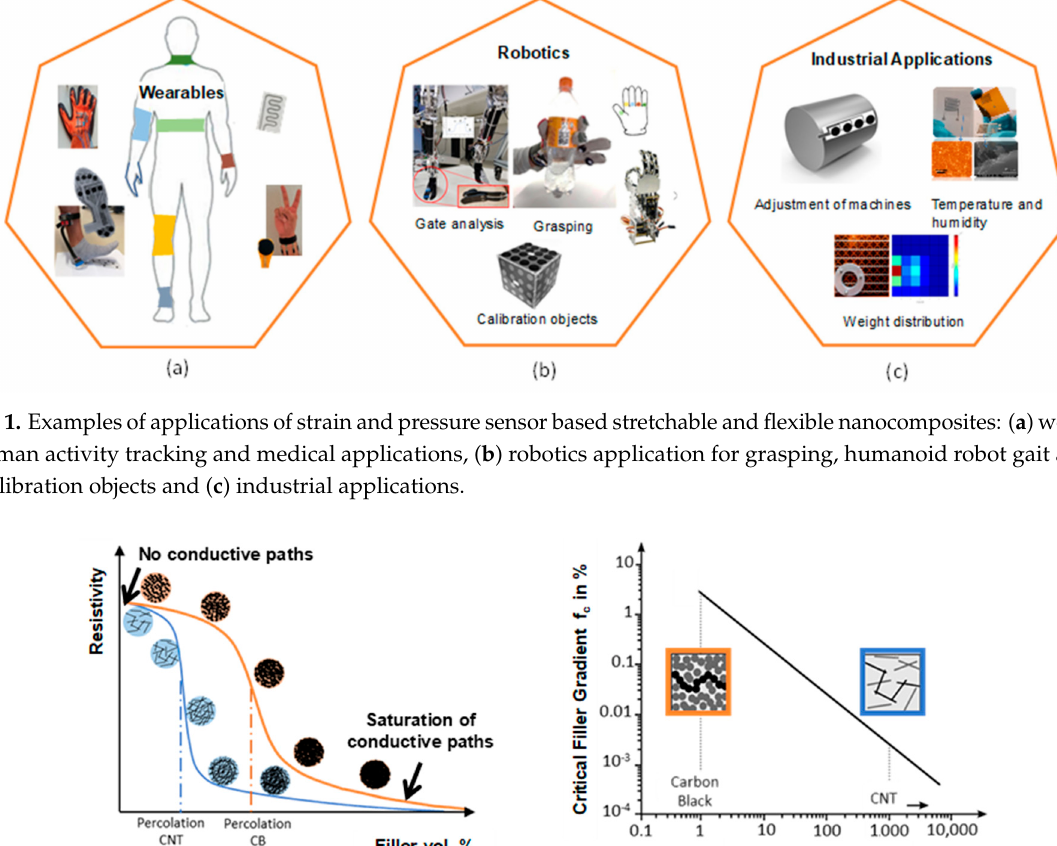
Figure 1. Examples of applications of strain and pressure sensor based stretchable and flexible nanocomposites: ( a ) wear- ables for human activity tracking and medical applications, ( b ) robotics application for grasping, humanoid robot gait analysis and calibration objects and ( c ) industrial applications.